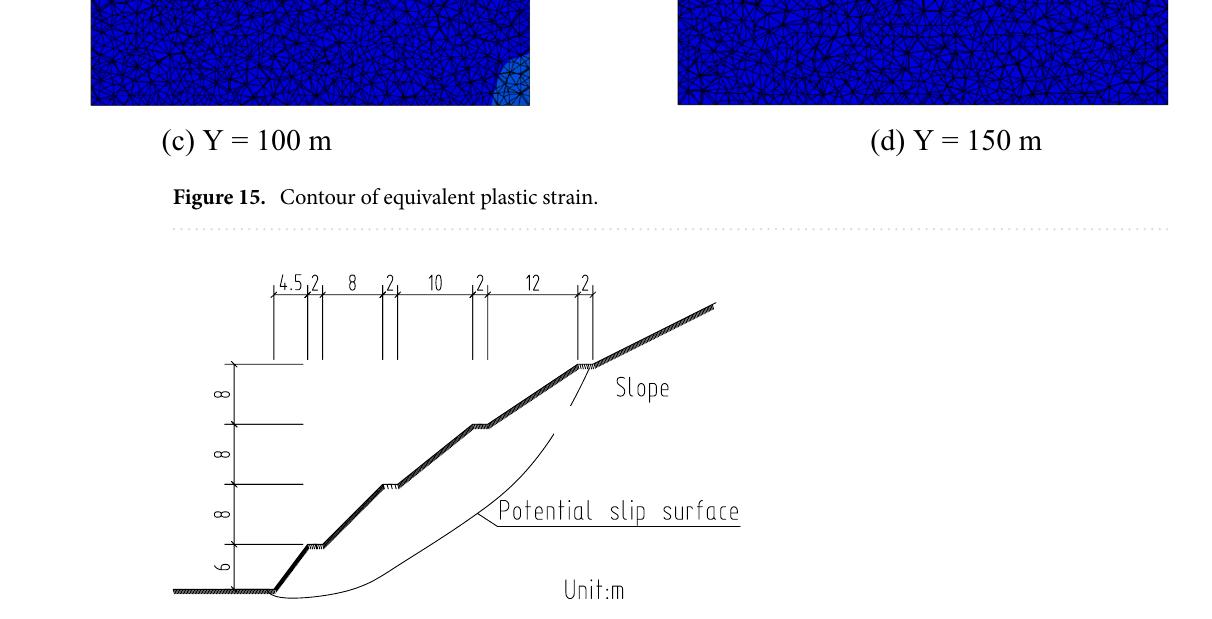
Figure 16. Position of potential slip surface at the top and foot of the